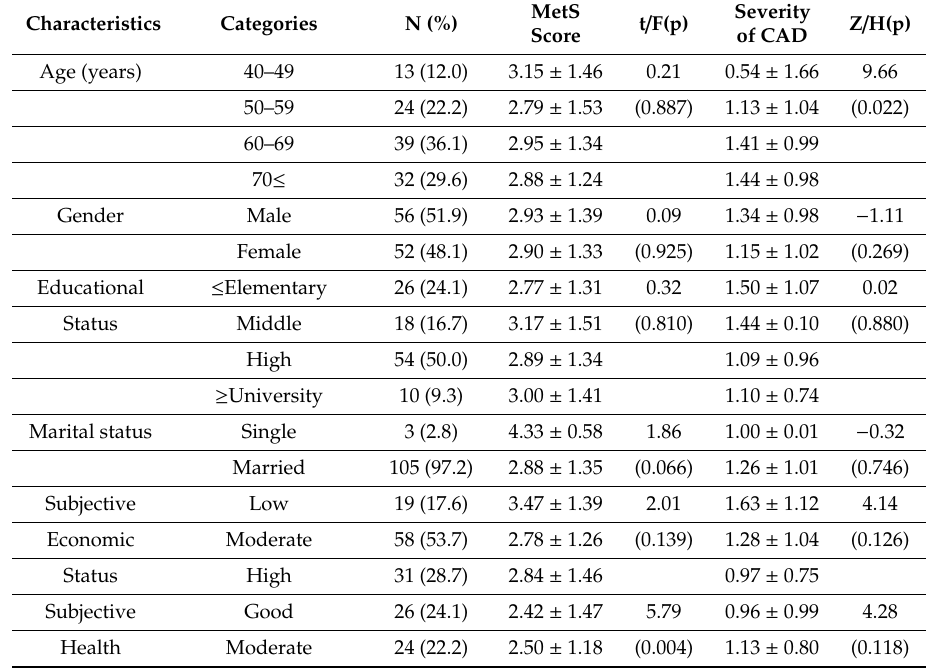
Table 1. Predictors of coronary artery disease (CAD) prognosis according to participant characteristics ( N =